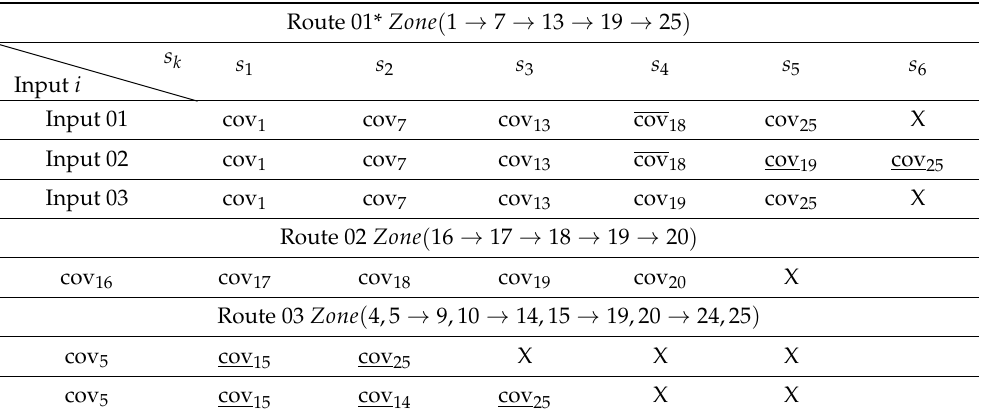
Table 2. The Inputs of TBM.